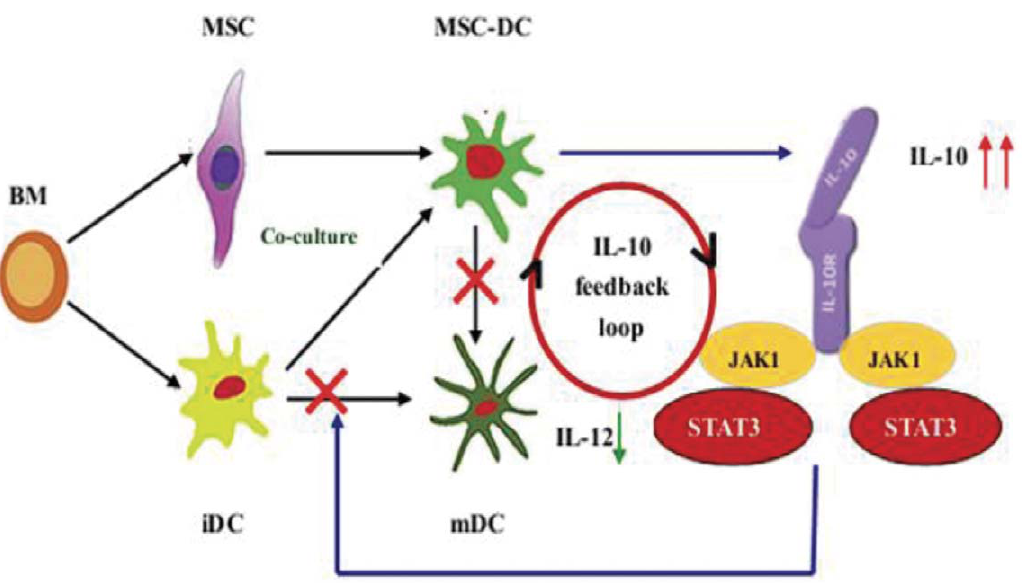
Figure 9. Newly proposed IL-10 feedback loop. The figure illustrates the interplay between IL-10 and the JAK1/STAT3 signaling pathway involved in mechanism inhibition of DCs maturation by MSCs. The MSCs facilitate the combination of the cytokine IL-10 with its IL-10 receptor. This complex activates the JAK1/STAT3 signaling pathway that suppresses the DCs maturation. This inhibition of maturation causes a decrease in the expression of IL-10. Thus, the levels of the cytokine IL-10 command this positive feedback